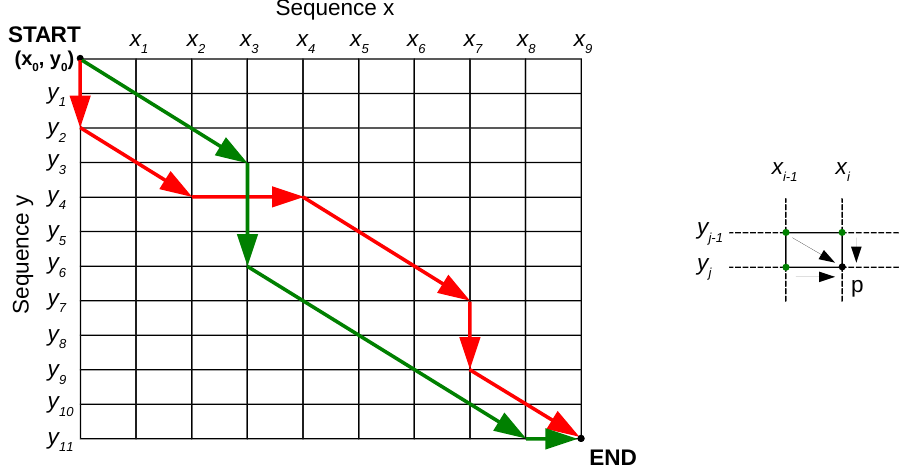
Figure 3. Dynamic time warping: alignment of two sequences. Two possible warping paths ( Left ) and a detail of the prolongation of a path ( Right